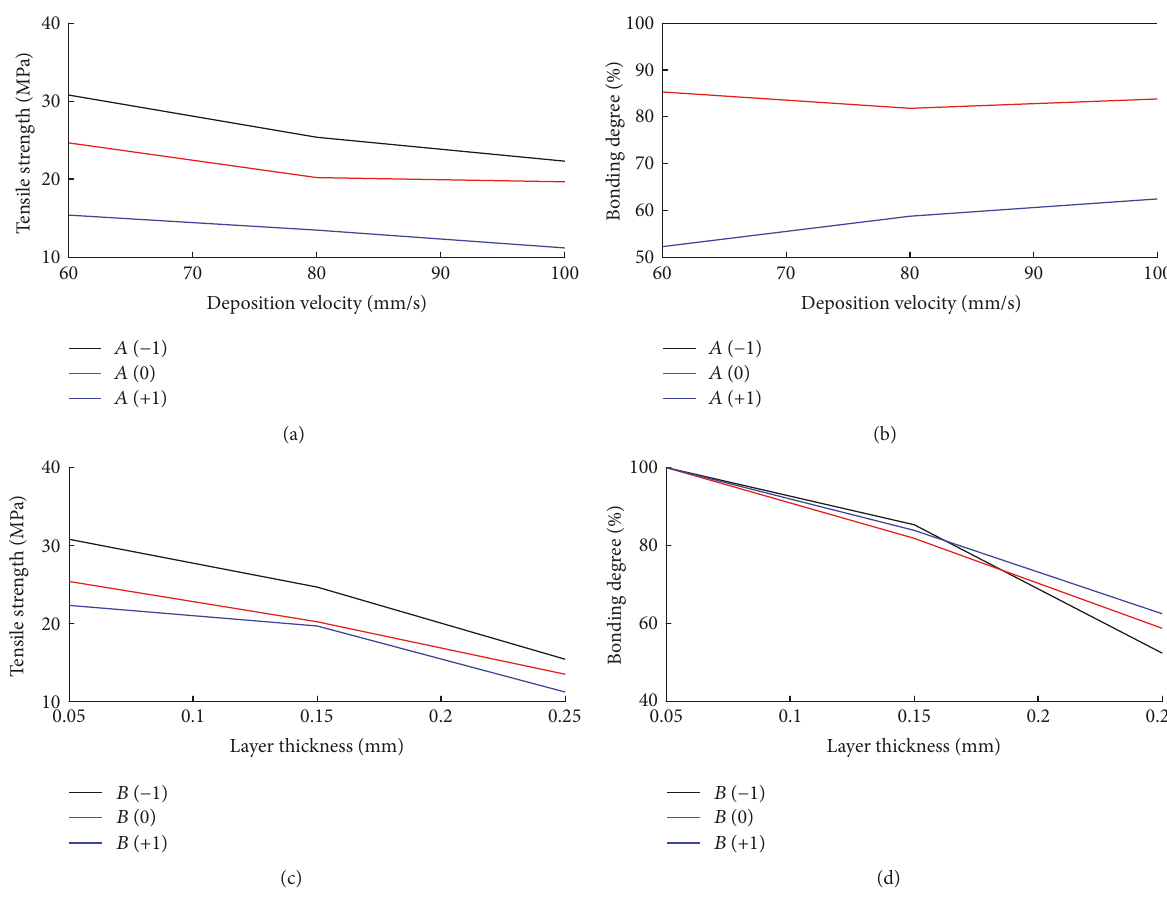
Figure 4: (a) shows the change of tensile strength with increasing of deposition velocity under different layer thickness level; (b) shows the changing of bonding degree; (c) shows the tensile strength change with the increasing of layer thickness under different level of deposition velocities; (d) shows the bonding degree change of the same